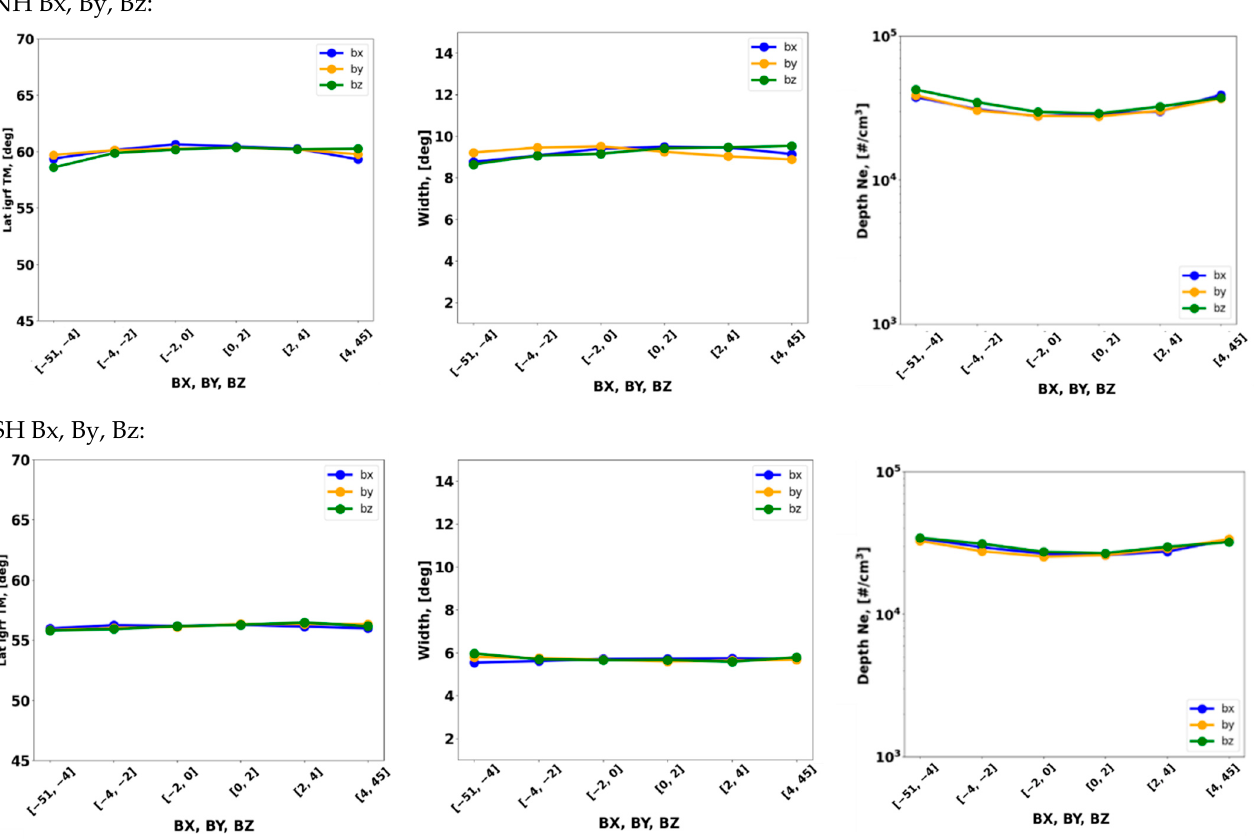
Figure 17. Bx (blue), By (orange), and Bz (green) component dependence of the trough minimum position, trough width, and trough depth for the northern and southern